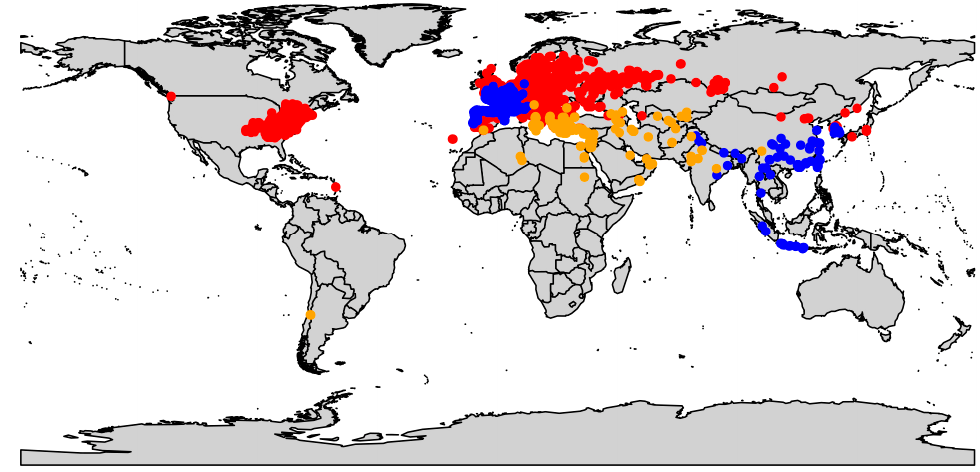
Figure 1. Global distribution of Vespa velutina (blue), V. crabro (red) and V. orientalis (orange). The temporal range of the data is 1990–2021.